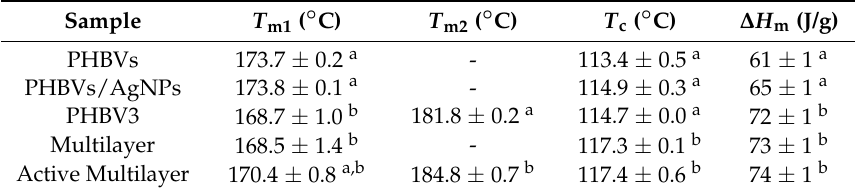
Mean values ± standard deviation. Mean values with different superscript letters in the same column represent significant differences ( p < 0.05) among the samples according to ANOVA and Tukey’s multiple comparison tests.